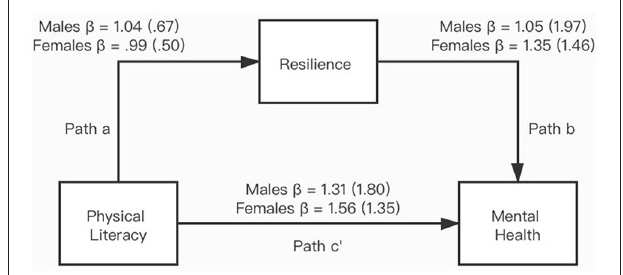
FIGURE 1 | Graphical representation of the mediation model of resilience for physical literacy and mental health.